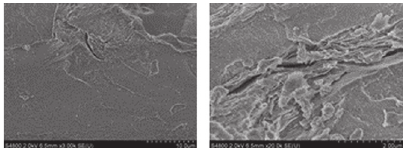
Figure 3: SEM images of the Bulianta 12# raw coal sample before (a) and after (b) water